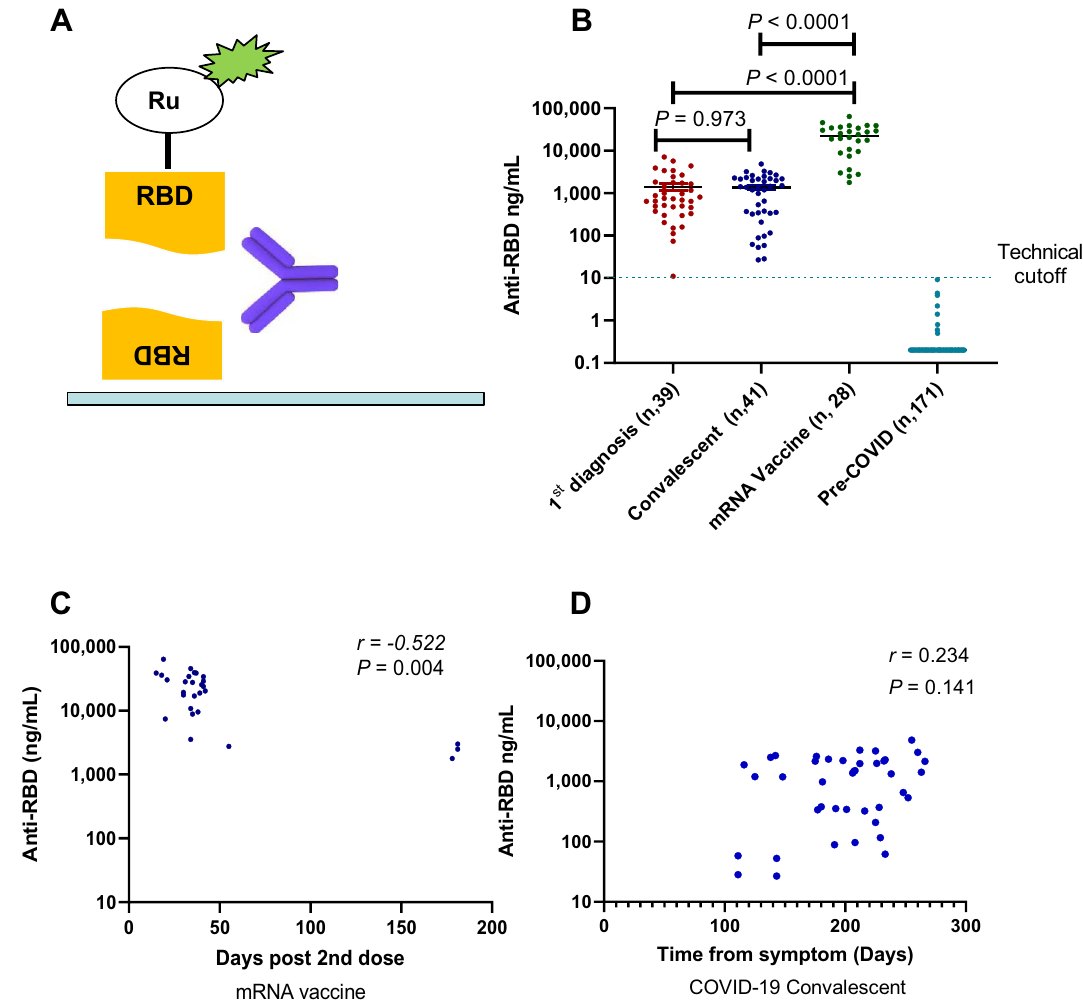
Figure 1. COVID-19 serology assay and antibody levels. ( A ) Diagram of the serology assay using electrochemiluminescence detection method. The capture RBD protein was attached to the assay plate via biotin and the detection RBD was conjugated to the voltage-sensitive ruthenium (Ru) molecule to emit light. ( B ) Quantitative RBD antibody data from sera samples of three cohorts: (1) samples on the first seropositive test, (2) convalescent donors with documented COVID-19, (3) donors without prior COVID-19 and completed two doses of mRNA vaccines. Negative control samples were collected from healthy donors prior to Jan. 2020. ( C ) The RBD antibody levels and time association in vaccinated donors ( r = − 0.522, P = 0.0044). ( D ) Lack of RBD antibody levels and time association in COVID-19 convalescent donors ( r = 0.234, P =